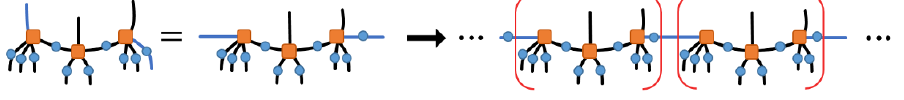
h 1 1 1 i , we can de(cid:12)ne loop body 3 2 3 (cid:17)